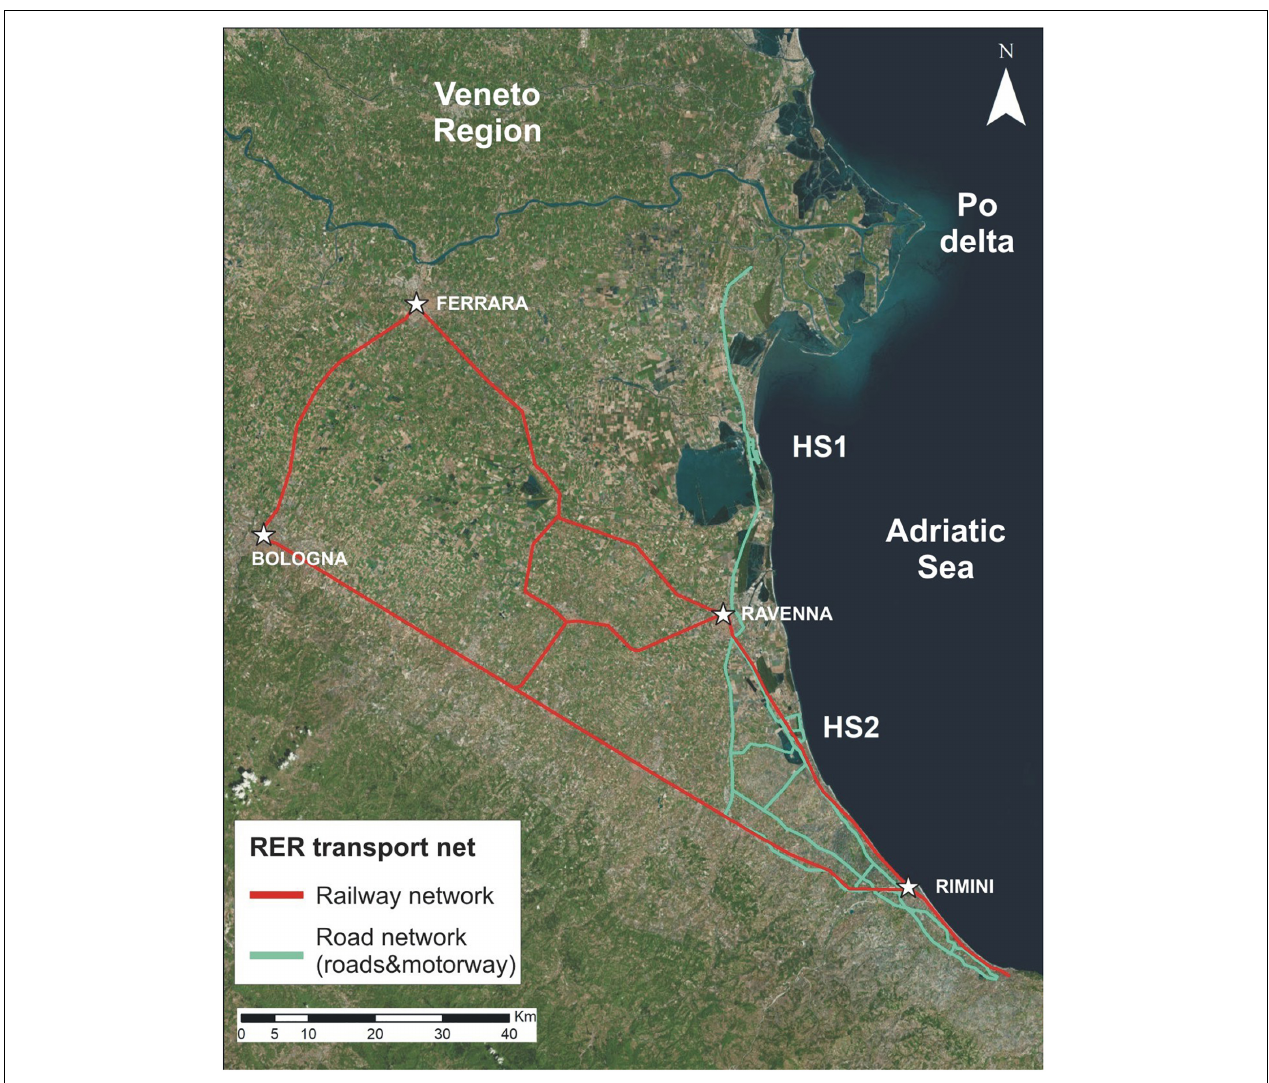
FIGURE 4 | Schematic of the transport network at the regional